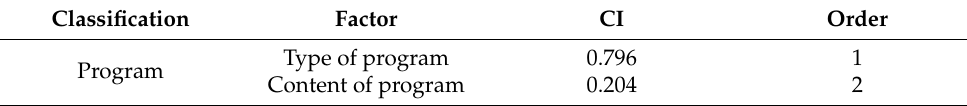
Table 3. Results of the relative importance of the program in H3.